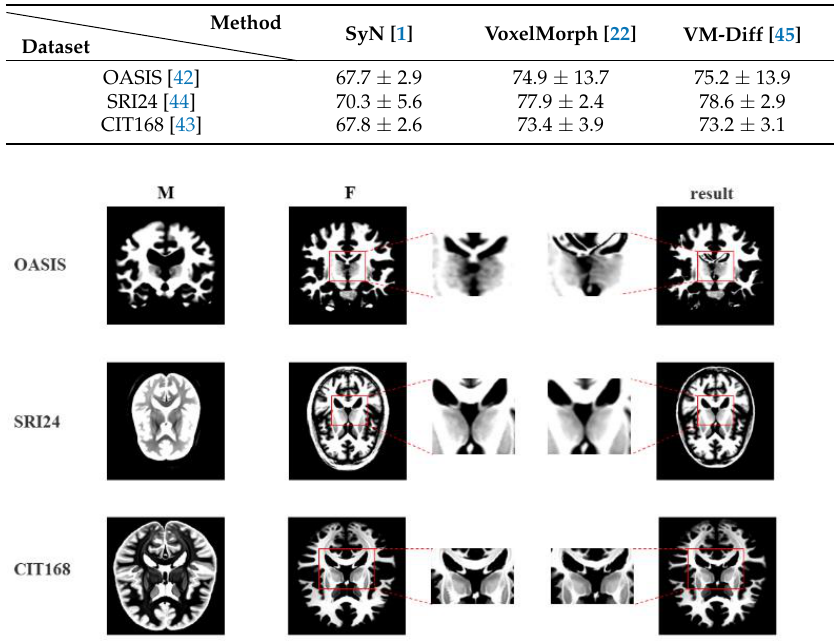
Table 3. Quantitative results on OASIS, CIT168, and SRI24 datasets. Bold indicates the highest DSC score.